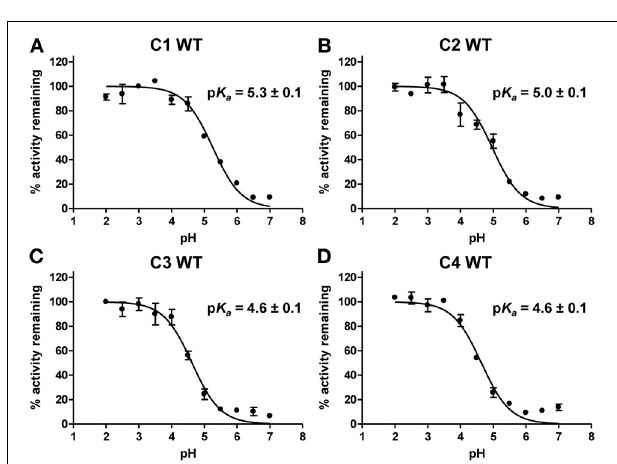
FIGURE 5 | p K a determination of the catalytic cysteine of poplar GrxC1, C2, C3, and C4. Reduced GrxC1 (A) , GrxC2 (B) , GrxC3 (C) , and GrxC4 (D) WT proteins were incubated in different buffers ranging from pH 2.0 to 7.0 in presence or not of iodoacetamide (IAM) prior to measurement of their activity by using the HED assay. The percentages of remaining activity at each pH were determined by comparing the activity of the enzyme incubated with and without IAM and an adaptation of the Henderson–Hasselbach equation was used for p K a value determination. The data are represented as mean ± SD of three separate experiments.